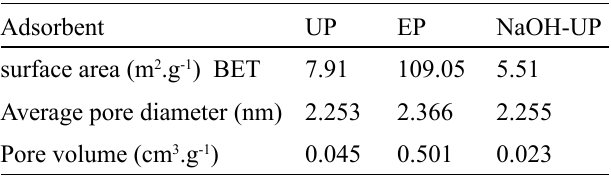
Table 2. The BET analysis results.